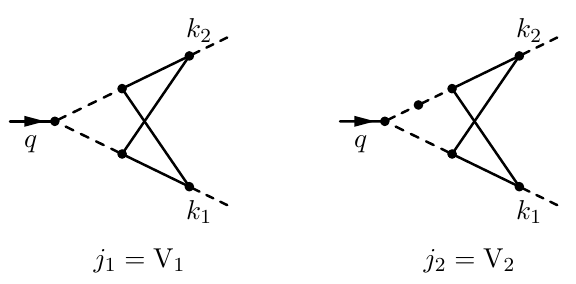
Figure 3 . The two-loop nonplanar vertex topology, k 2